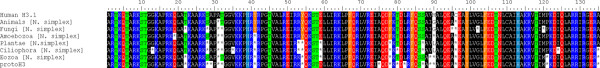
Reconstruction of ancestral histone H3 states. The ancestral state reconstruction of histone H3 variants from various clades (corresponding nodes are highlighted in the group-specific phylogenetic trees by red rhombs in Figure 2B) and H3 variant(s) of LECA confirms a high degree of sequence identity or similarity, respectively (shaded columns). Variable sites are highlighted (*); color scheme: basic amino acids (blue), acidic amino acids (red), aromatic amino acids (orange), putative phosphorylation sites (green). Nuclearia simplex H3 was used as outgroup for all group-specific trees. A detailed overview about the most frequent residues observed at such variable site is given in Additional file 4.